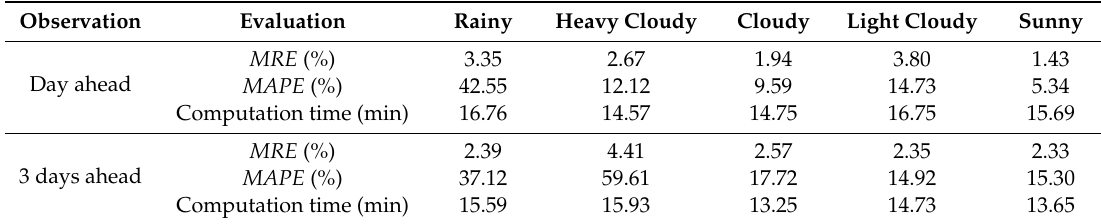
Table 4. Proposed PV power forecasting